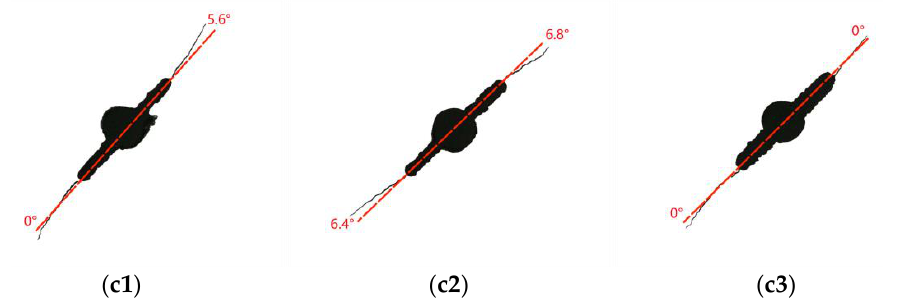
Figure 4. Propagation path under crack inclination angle 45°. ( a1 ) β = 45°, λ = 0, R = 0. ( a2 ) β = 45°, λ = 0, R = 0.1. ( a3 ) β = 45°, λ = 0, R = 0.3. ( b1 ) β = 45°, λ = 0.5, R = 0. ( b2 ) β = 45°, λ = 0.5, R = 0.1. ( b3 ) β = 45°, λ = 0.5, R = 0.3. ( c1 ) β = 45°, λ = 1, R = 0. ( c2 ) β = 45°, λ = 1, R = 0.1. ( c3 ) β = 45°, λ = 1, R = 0.3.